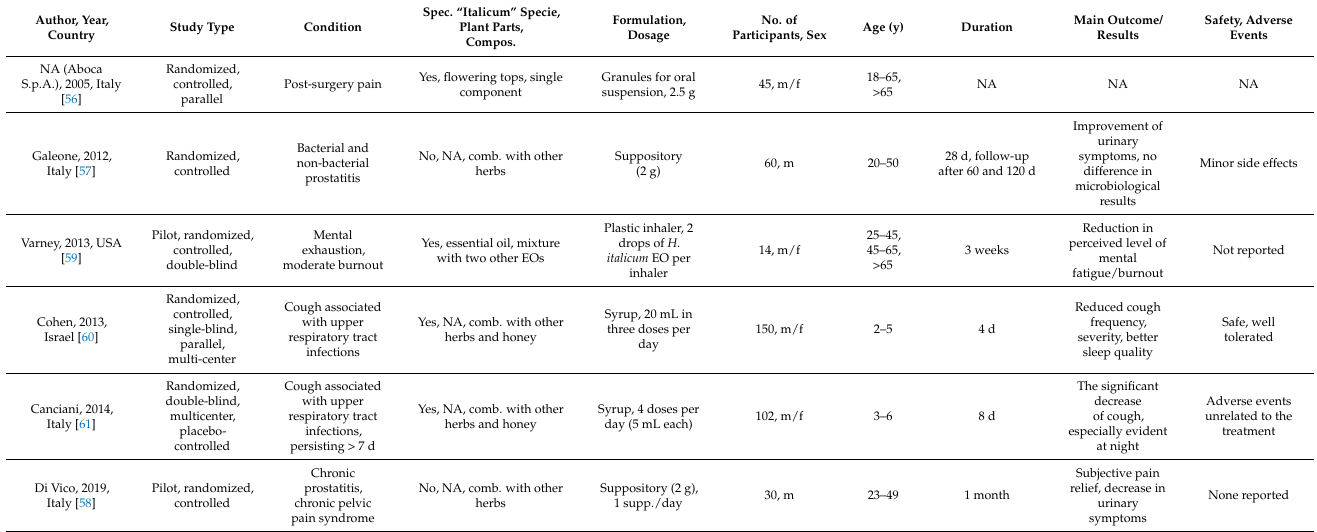
Table A1. Characteristics of included clinical trials, listed in chronological